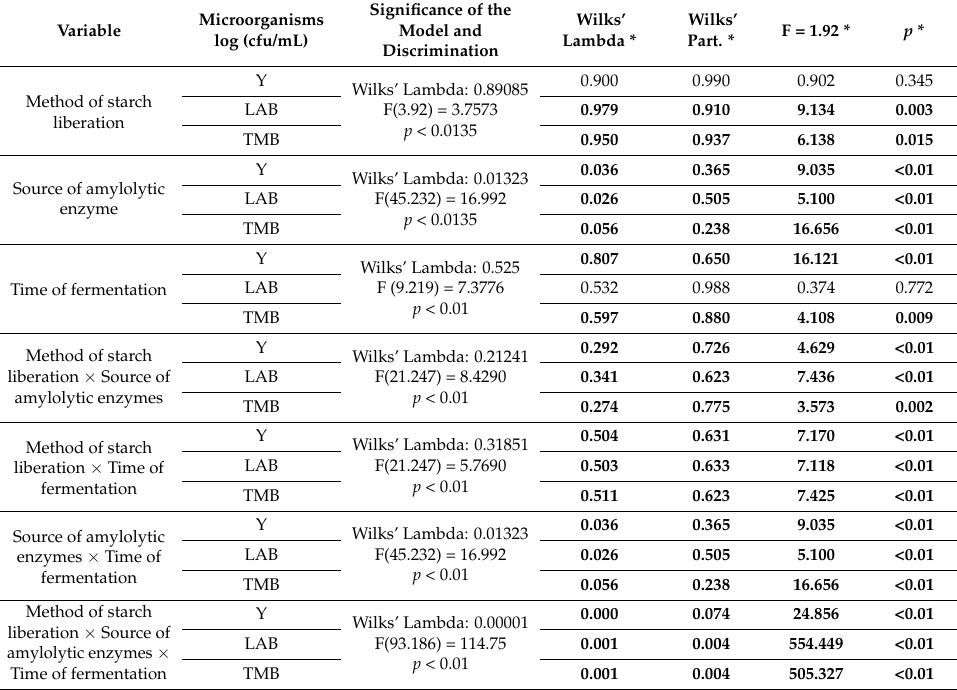
Table 6. Results of discriminant function